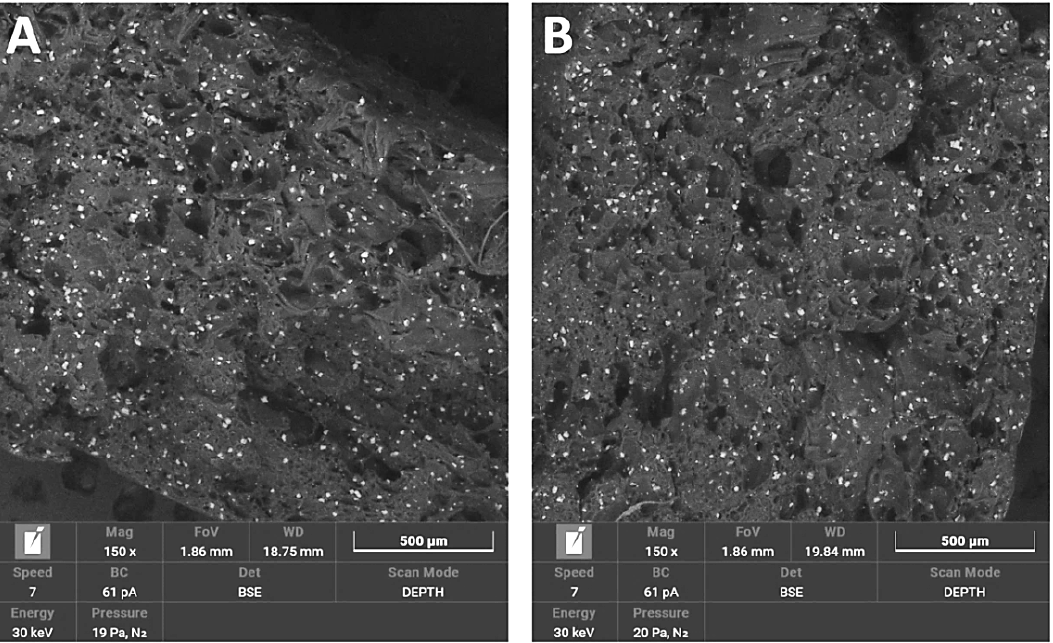
Figure 14. SEM micrographs used to compare breakthroughs of ( A ) PA12_ Al 2 O 3 _NS and ( B ) PA12_ Al 2 O 3 _S